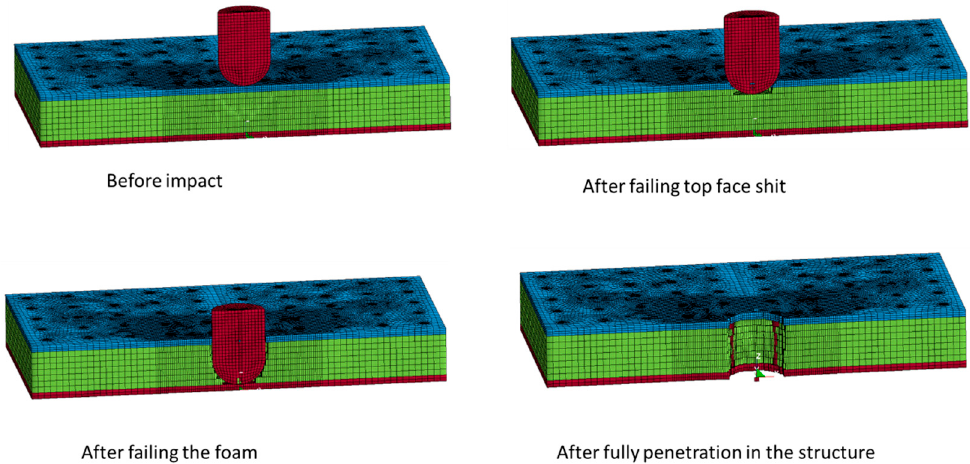
Figure 7. Failure process of a half cross-section of a 3 mm PFCS panel subjected to 500 mm/min over the time.